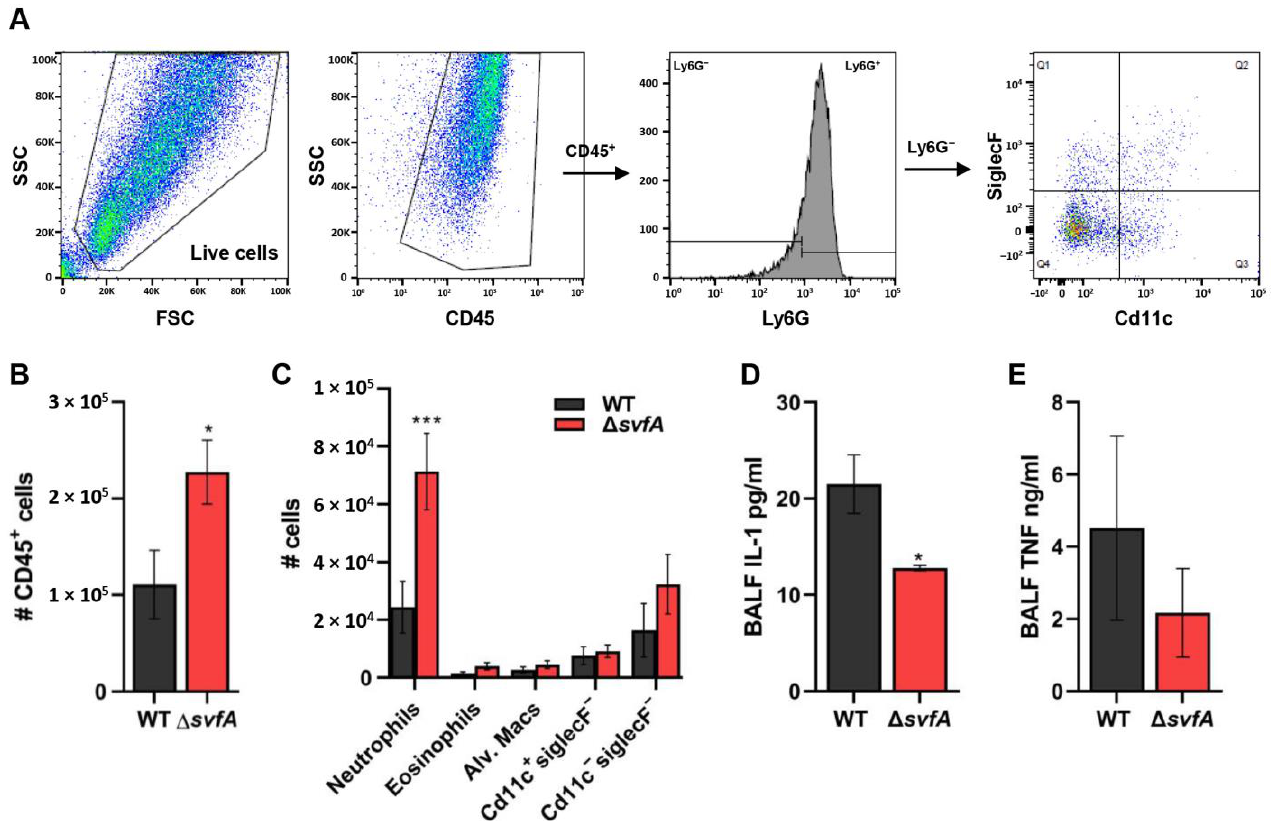
Figure 8. Lung inflammatory responses from the CGD mice after A. nidulans aspiration. ( A ). Repre- sentative flow cytometric dot plots. BAL cells were isolated from A. nidulans WT- and ∆ svfA -conidia- aspirated mice at 5 d post-infection. The number of cells was determined using flow cytometry. N = 6–8/group. ( B ) Total number of CD45 hi cells. N = 6–8/group. * p < 0.05. ( C ) Number of Ly6G hi neutrophils, Ly6G lo CD11c lo SiglecF hi eosinophils, Ly6G lo CD11c hi SiglecF hi alveolar macrophages, CD45 hi Ly6G lo CD11c hi SiglecF lo cells, and CD45 hi Ly6G lo CD11c lo SiglecF lo cells. N = 6–8/group. *** p < 0.001. ( D ) Interleukin (IL)-1 α and ( E ) TNF- α concentration in BAL cells of the CGD mice quantified at the protein level using ELISA. N = 4–5/group. Data are a summary of two independent experiments. * p <